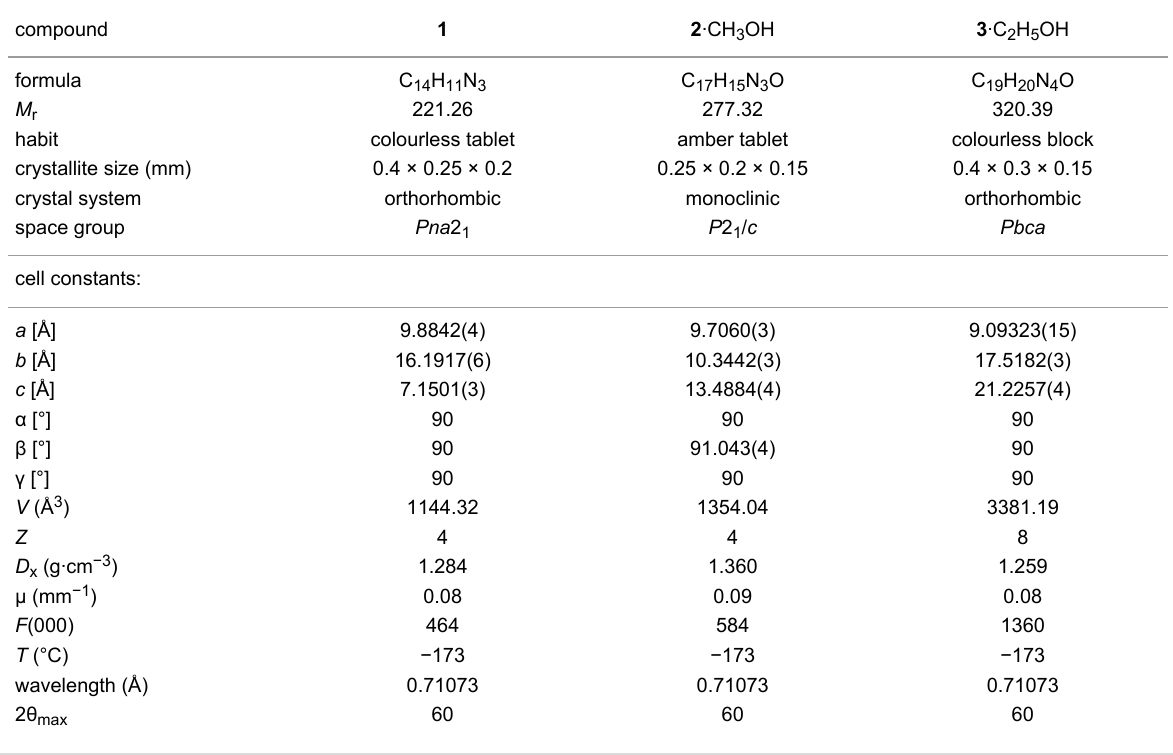
Table 2: Crystallographic data for compounds 1 , 2 ·CH 3 OH, 3 ·C 2 H 5